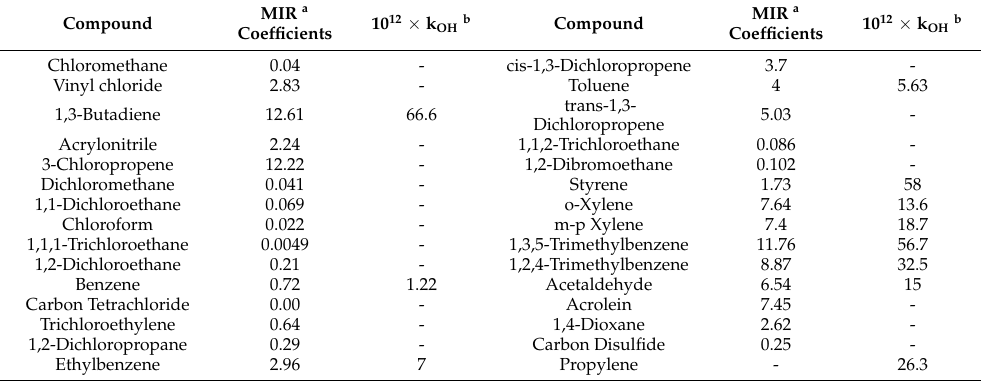
Table 2. MIR and OH reaction rate constant of each